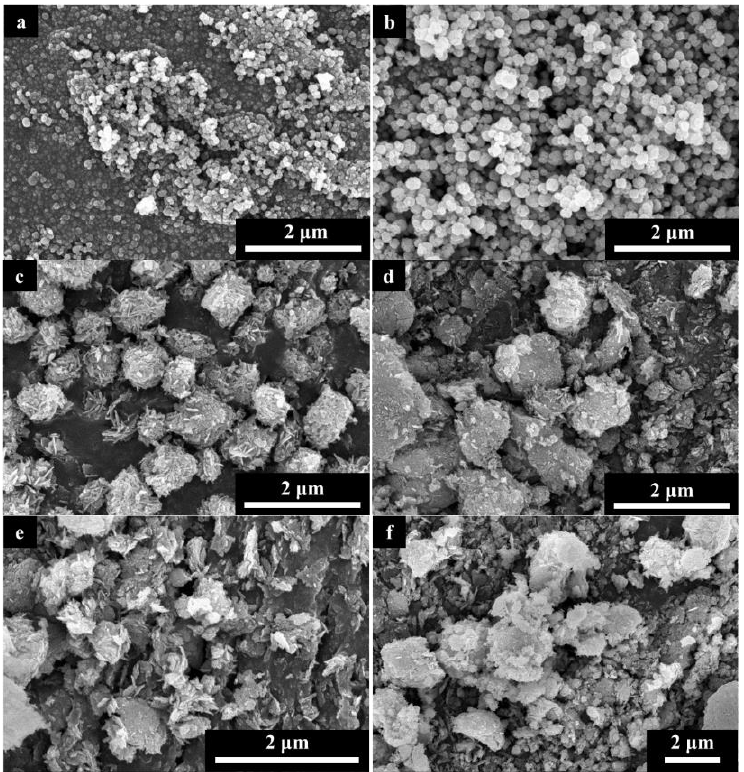
Figure 3. SEM micrographs of SrTiO 3 photocatalysts prepared at ( a ) 0.25, ( b ) 0.5, ( c ) 1, ( d ) 2, ( e ) 4, and ( f ) 8 EG:H 2 O ratios.